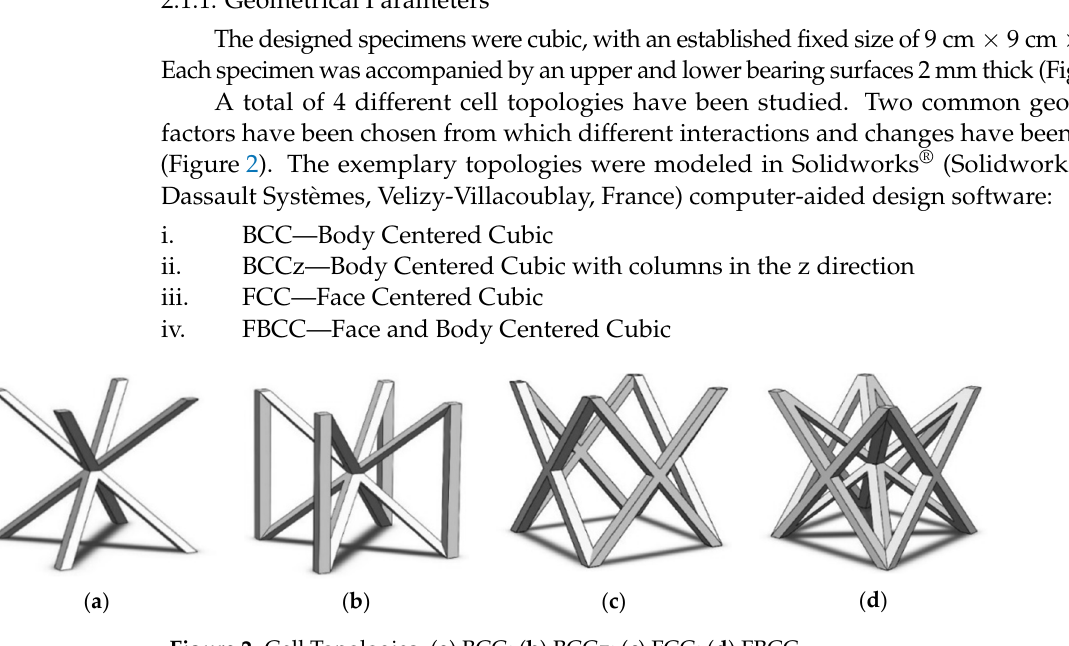
Figure 2. Cell Topologies. ( a ) BCC; ( b ) BCCz; ( c ) FCC; ( d ) FBCC.